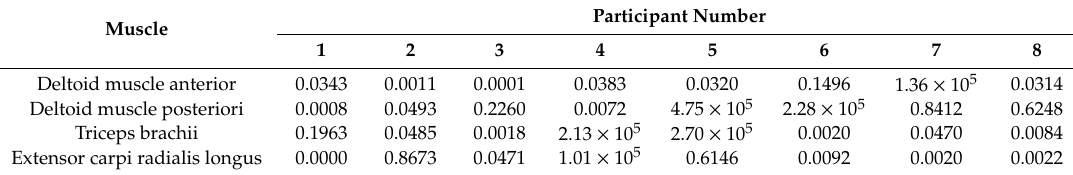
Table 8. The values of the student’s t -test for di ff erent muscles and participants.